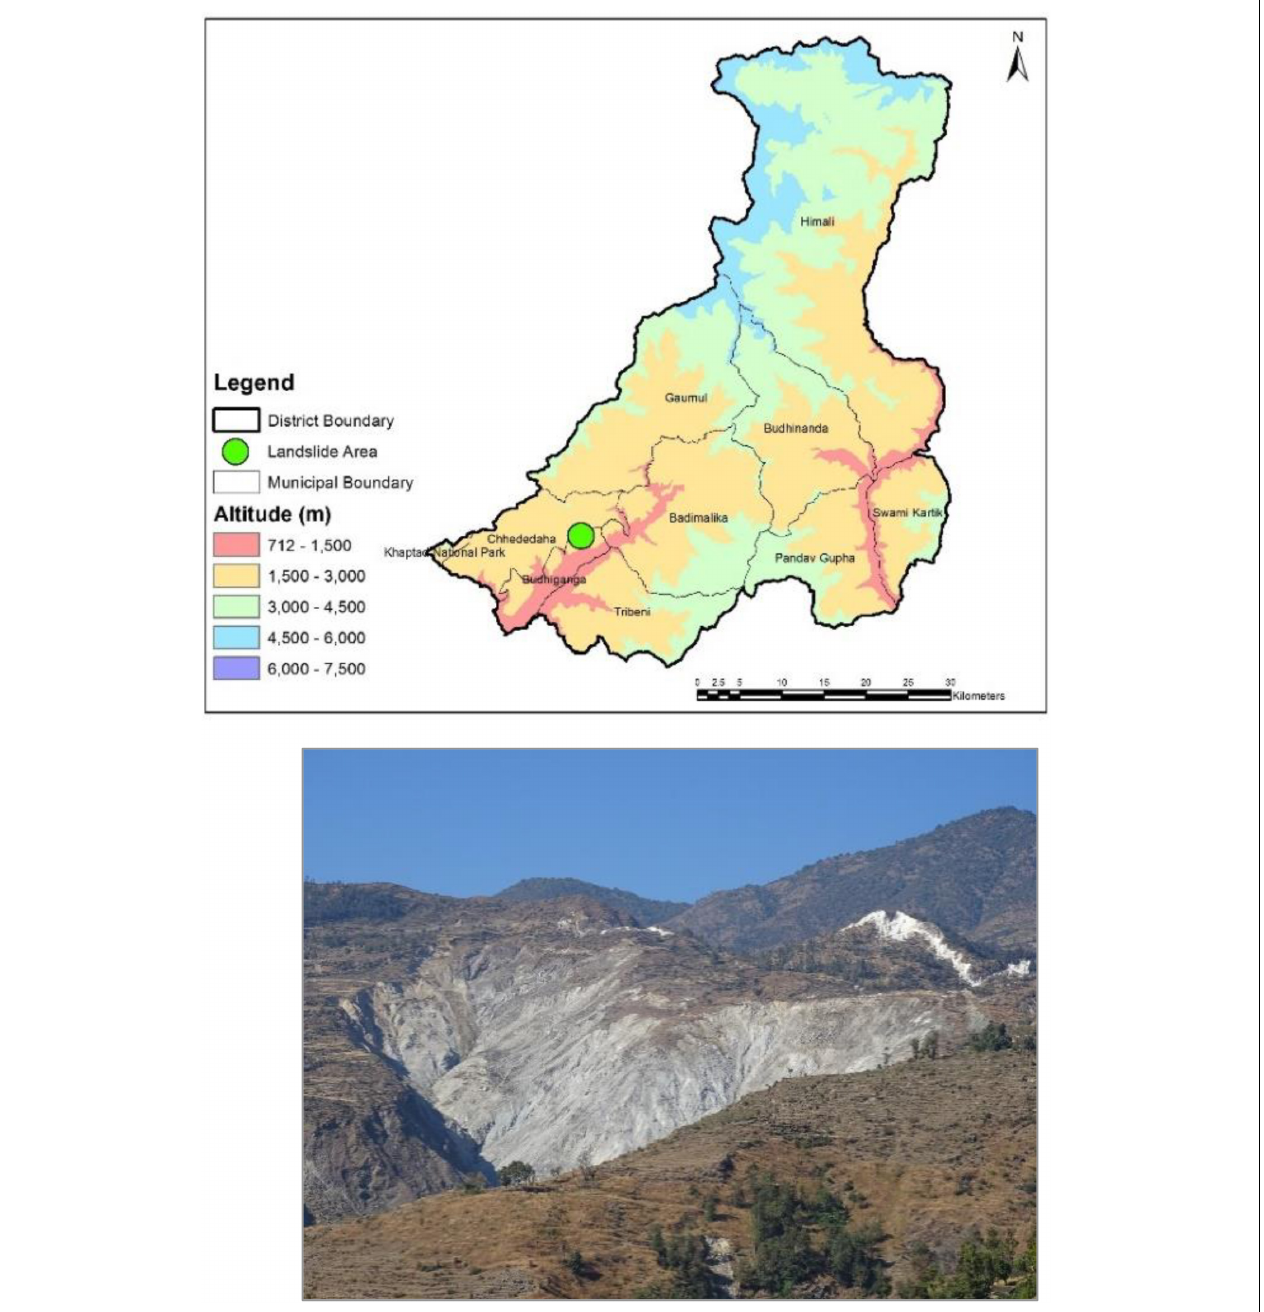
FIGURE 2 | The Bajedi landslide in